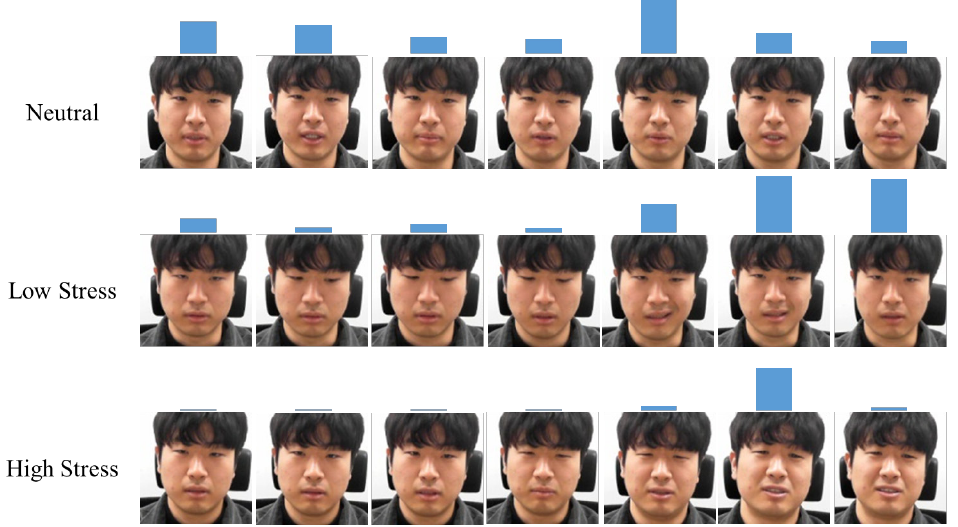
Figure 8. Visualization of the temporal attention weight in three stress states. The higher the height of the bar on the image, the greater the weight is. Table 11. The proposed method’s classification accuracy for each stress state with and without the facial landmark feature.